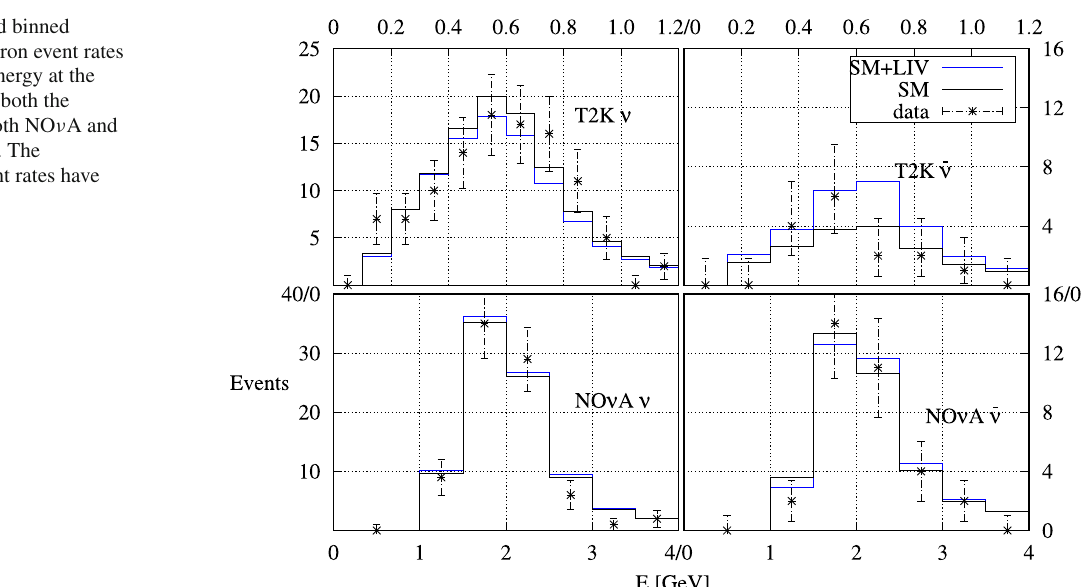
Fig. 12 Expected binned electron and positron event rates as a function of energy at the best-fit points for both the models and for both NO ν A and T2K experiments. The experimental event rates have also been plotted